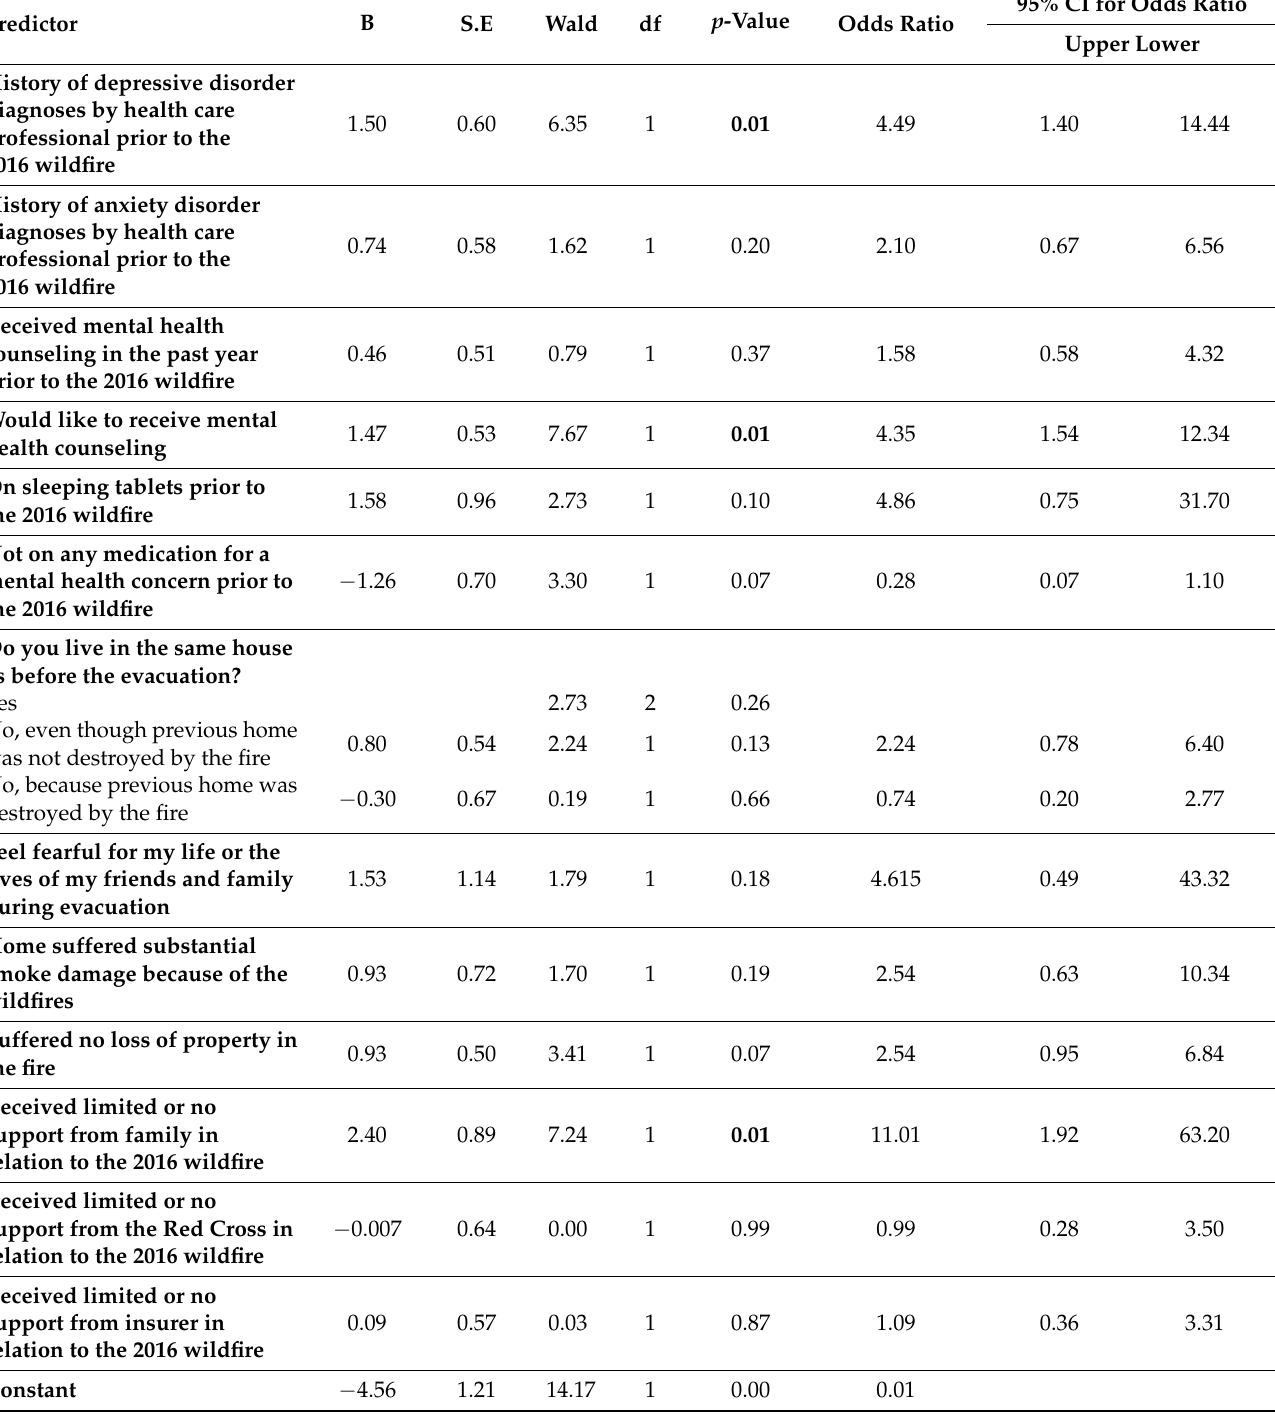
Table 4. Logistic regression predicting the likelihood of residents presenting with